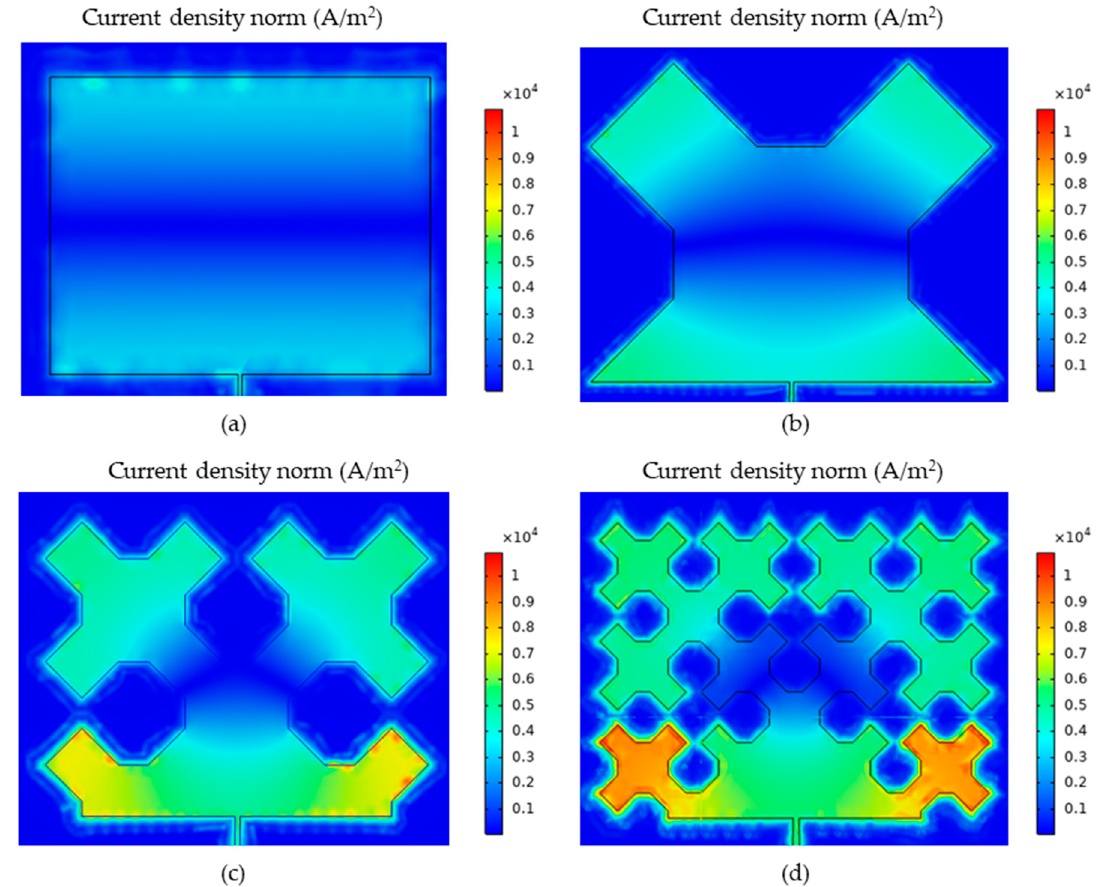
Figure 6. Current density distribution for resonant frequency; ( a ) rectangular patch; ( b ) Sierpinski curve fractal first iteration; ( c ) Sierpinski curve fractal second iteration; ( d ) Sierpinski curve fractal third iteration.